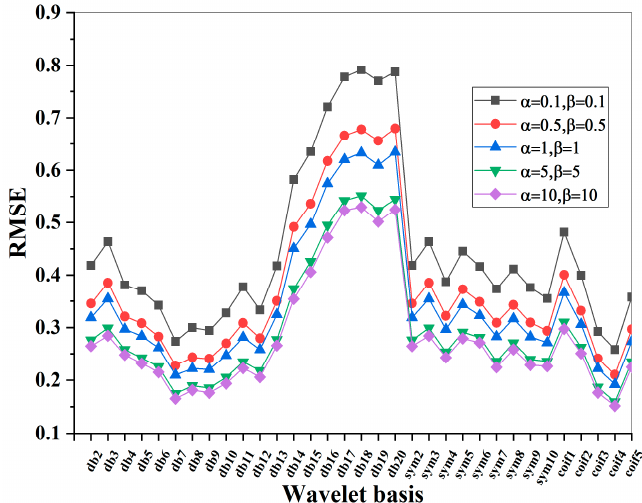
Figure 5. RMSE under different wavelet basis functions.